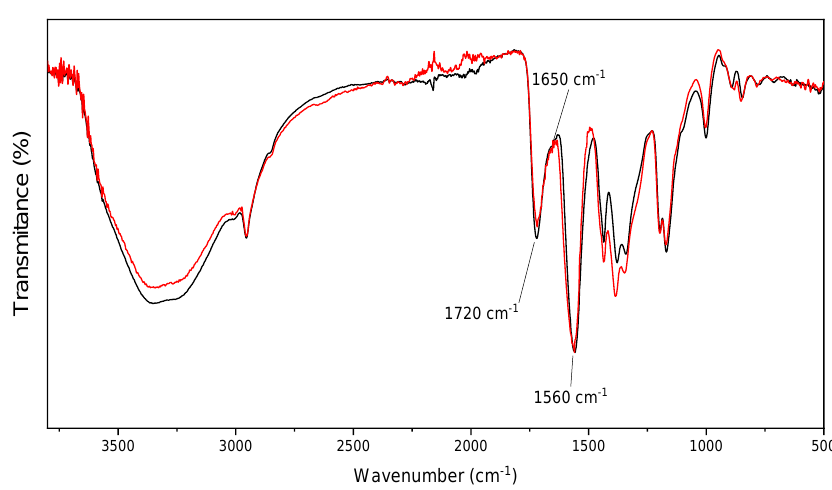
Figure 1. FTIR spectrum of PMMI (black line) and PMMI-Li + (red line).